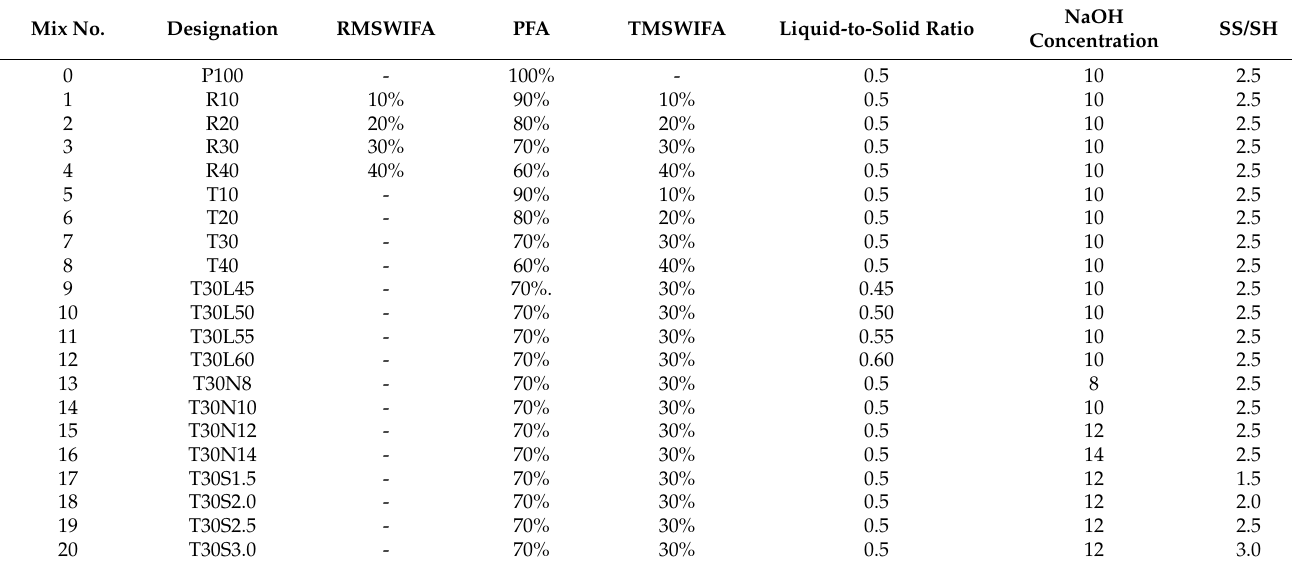
Table 2. Mix proposition of paste specimens (by